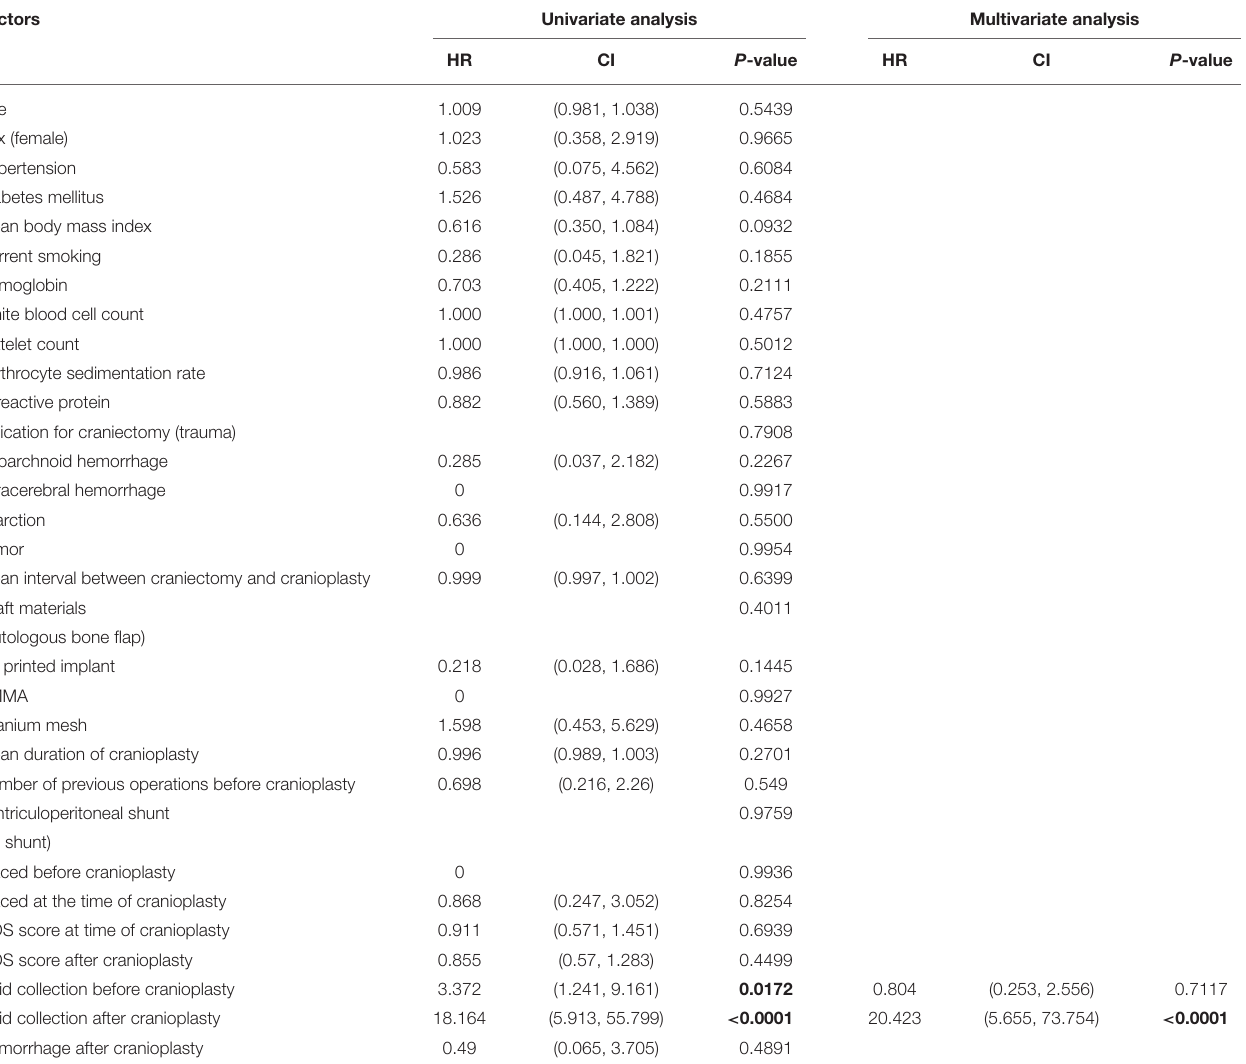
TABLE 2 | Predictive factors for time to surgical site infection following cranioplasty in 172 patients: Cox regression.